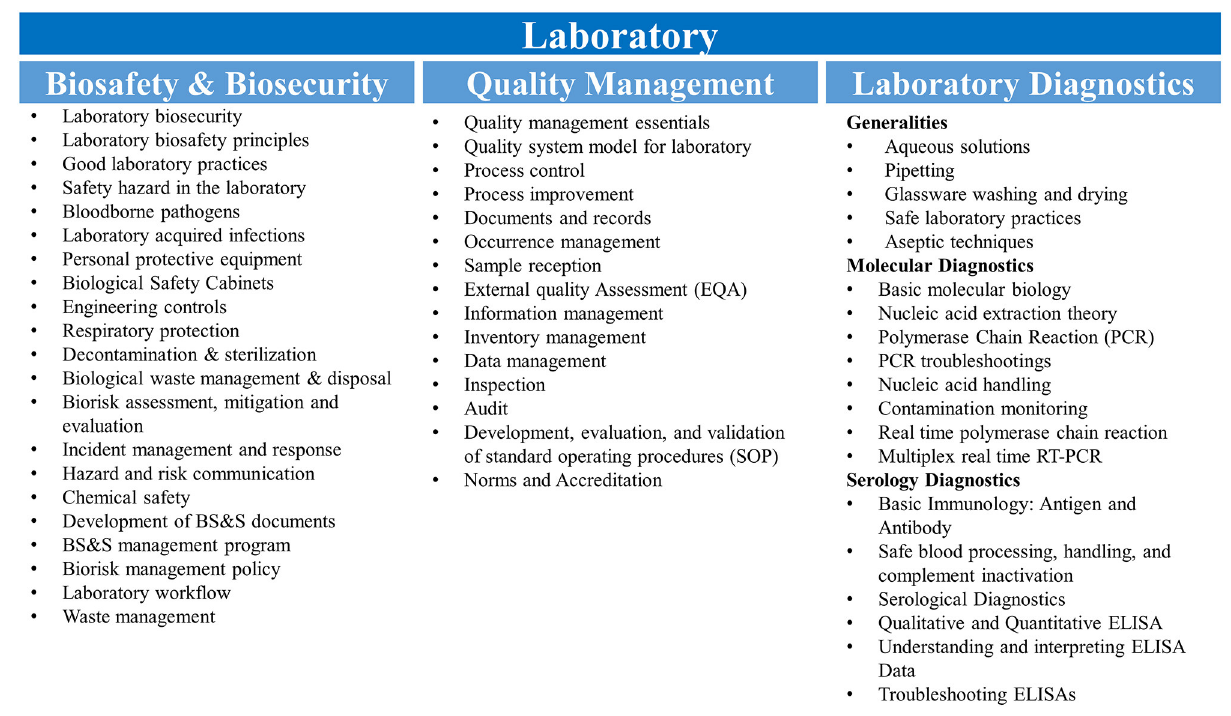
for laboratory personnel started in late 2016 and